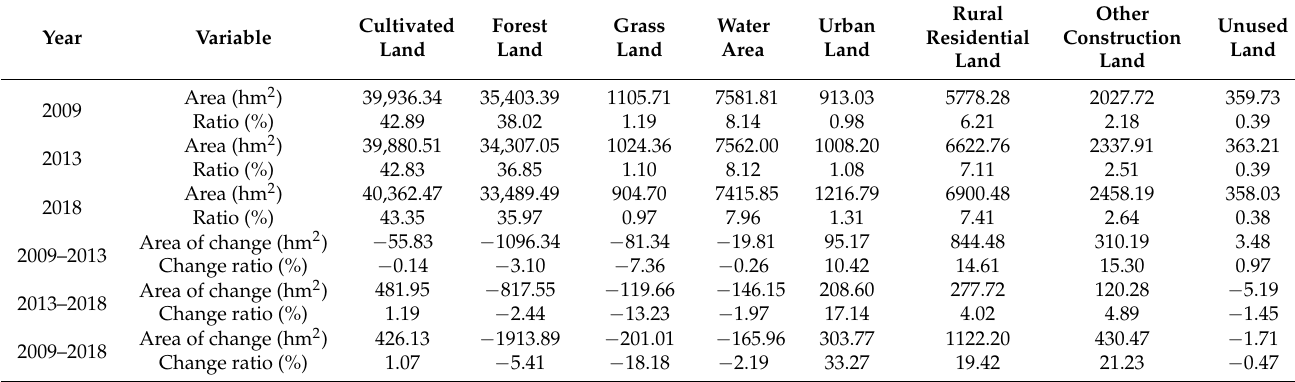
Table 1. Change of land use structure in Yujiang District from 2009 to